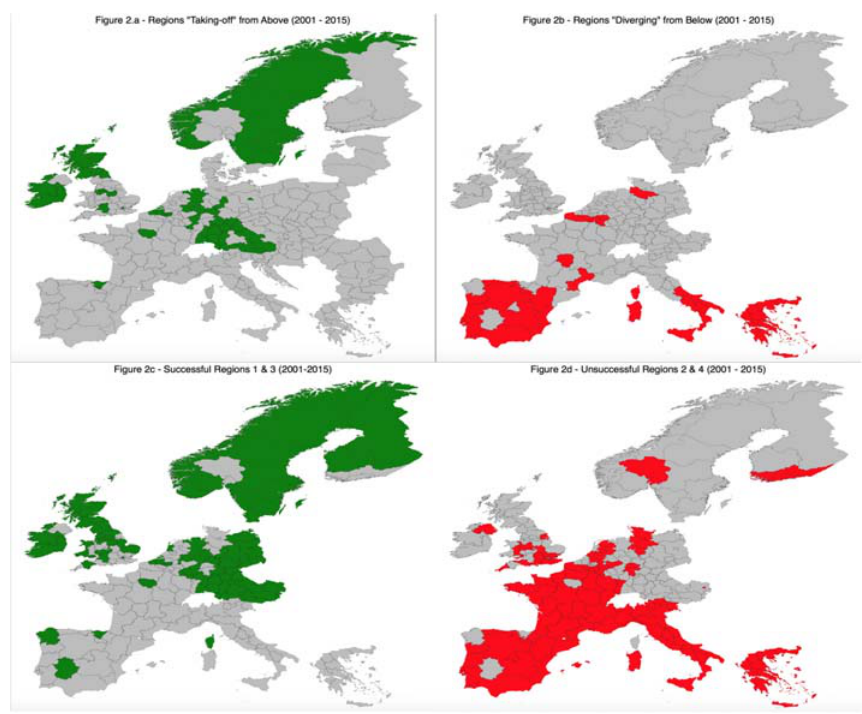
Figure 2 . Maps of regional performances.